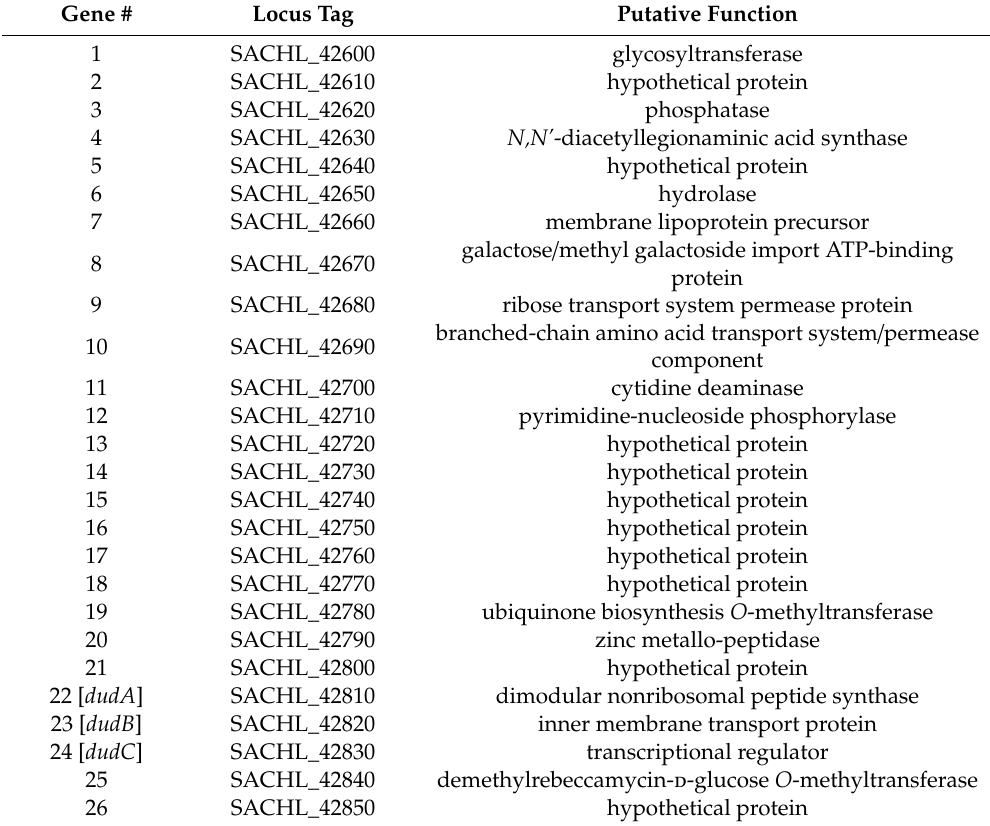
Table 1. Proposed functions of the genes in the DNA fragment containing the dudomycin gene